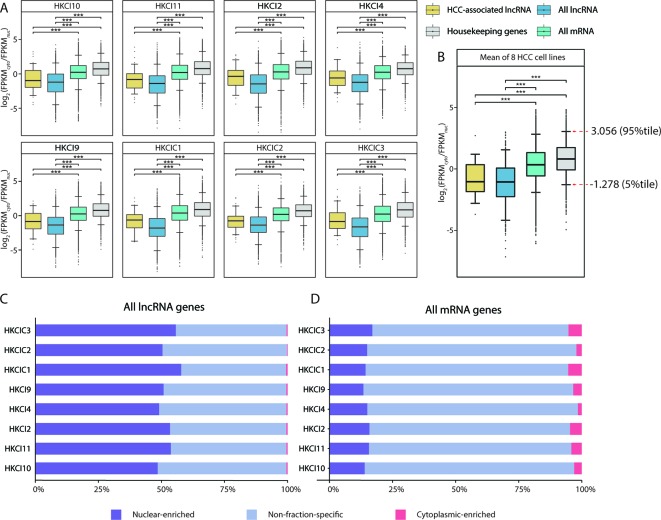
Subcellular distribution of RNAs in eight in-house hepatocellular carcinoma (HCC) cell lines. (A) Comparison of the RNA fraction distributions (gene expression FPKM ≥ 0.1 in both cytoplasm and nucleus) in different categories from eight in-house HCC cell lines. (B) Box plot of the RNA subcellular distribution based on the mean expression across eight cell lines. Pairwise comparisons were conducted using Mann-Whitney U test. All long noncoding RNA (lncRNA): All lncRNA genes (antisense and lincRNA biotype) annotated in GENCODE (v27); All mRNA: All mRNA genes annotated in GENCODE (v27); HCC-associated lncRNA: All HCC-associated lncRNAs revealed in this study; Housekeeping genes: Genes expressed uniformly across diverse tissues according to a study by Eisenberg et al.
(C, D) Distributions of mRNA and lncRNA genes according to enrichment patterns (nuclear-enriched/cytoplasm-enriched/non-fraction-specific) in subcellular fractions.